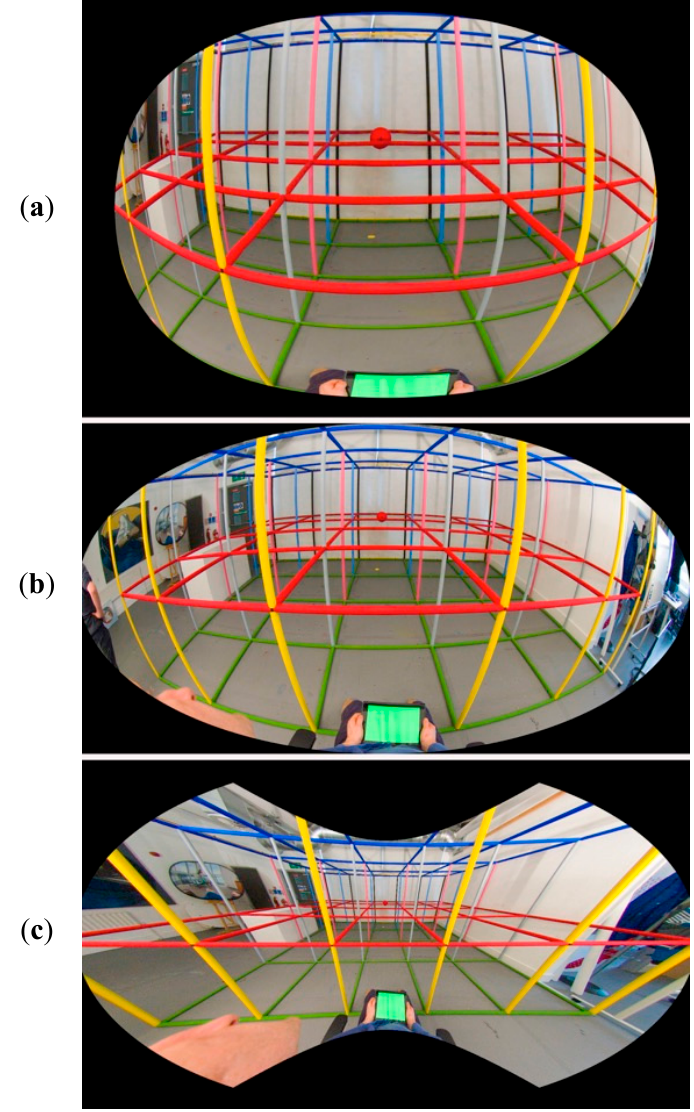
Figure 6. The photographic stimuli used in our experiments, consisting of three different photographs of the same 3D grid room. From top to bottom: ( a ) Natural Photograph (NP), ( b ) Fisheye Photograph (FP) and ( c ) Linear Photograph (LP).